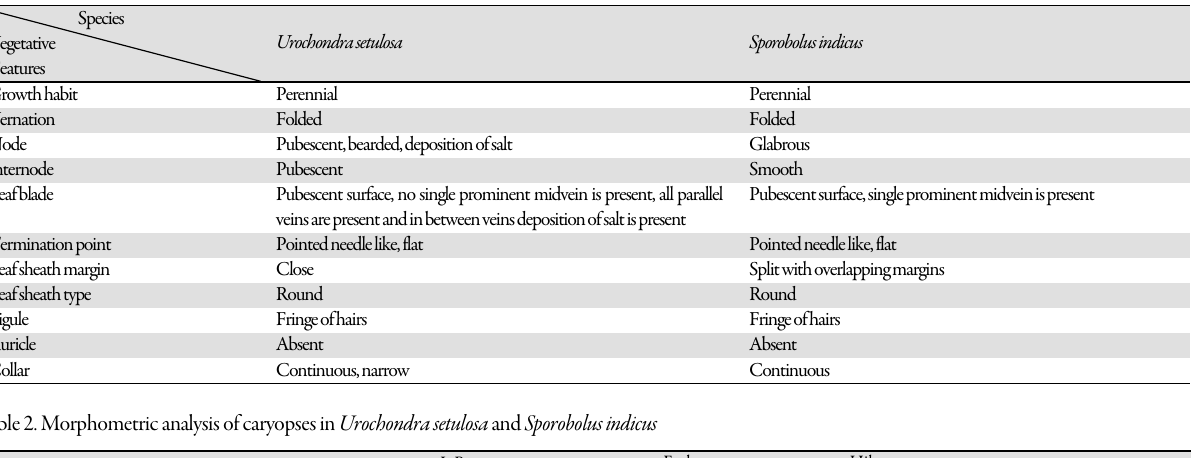
Table 1. Urochondra setulosa and Sporobolus indicus seedlings’ features